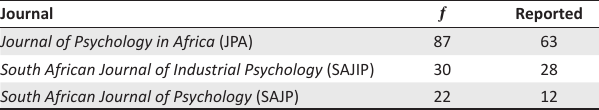
TABLE 1: Frequency of convenience sampling in African psychology journals.